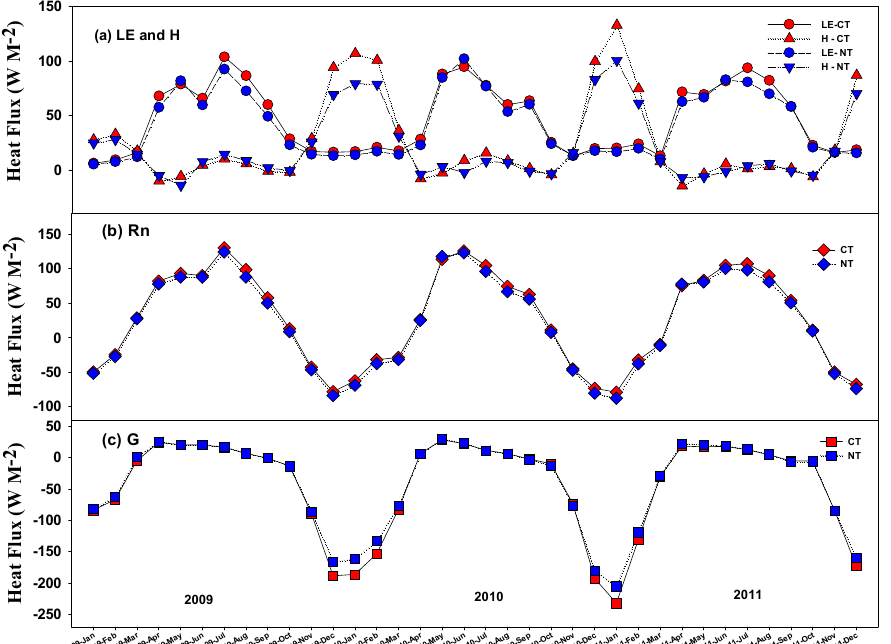
Figure 6. Simulated monthlysoil heat fluxes ( a ) LE, H and ( c ) G and ( b ) net radiation for CT and NT during 2009–2011.